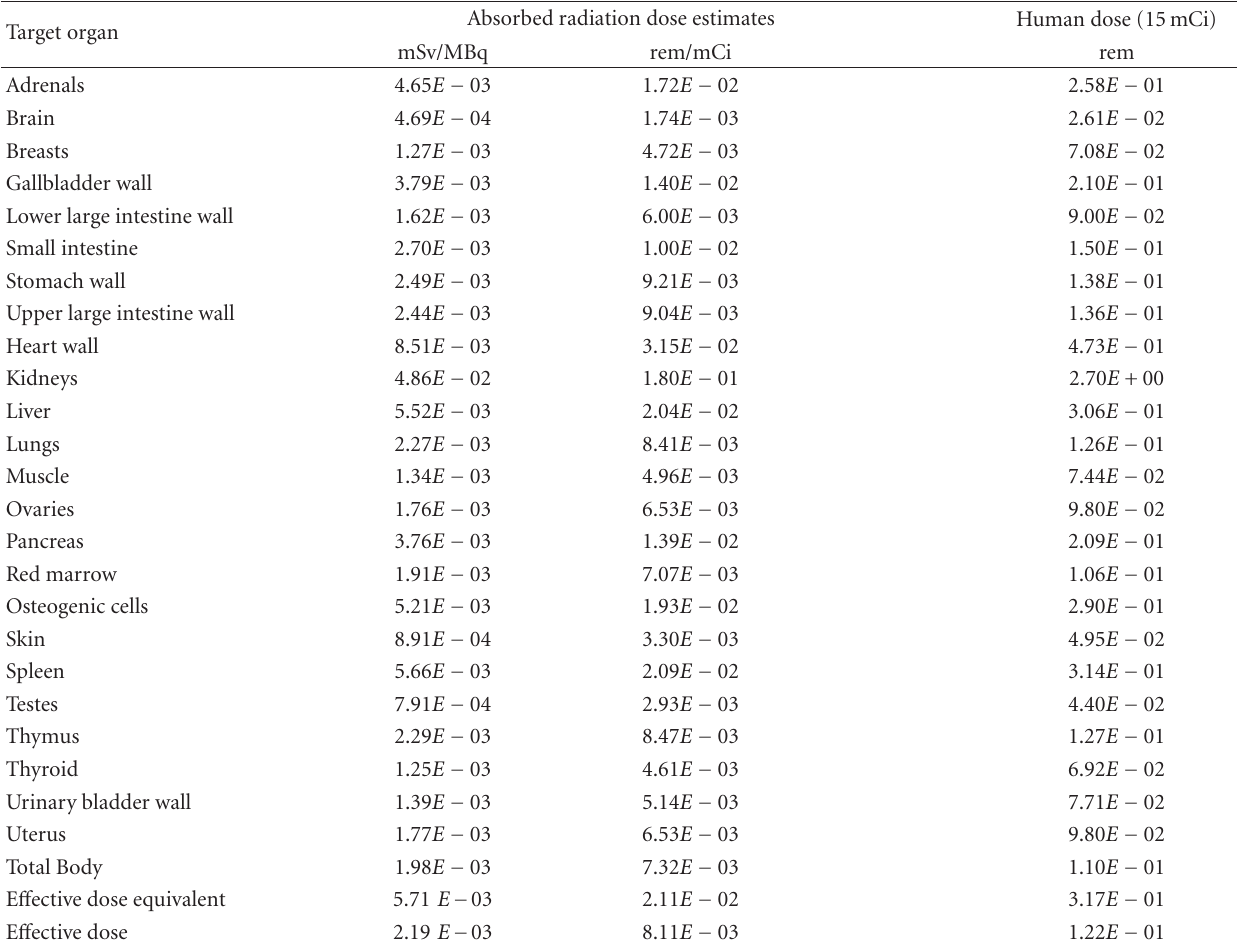
Absorbed radiation dose